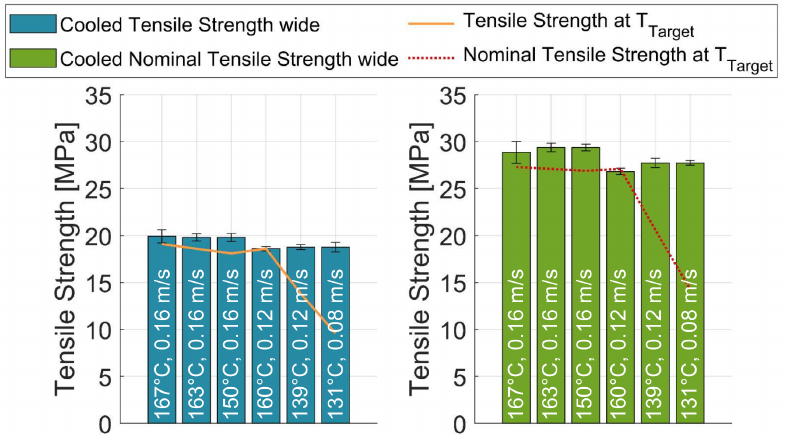
Figure 8. Standard and nominal transverse tensile strength of the cooled specimens at 100 mm cooling distance with the reference tensile strengths for unheated specimens at the achieved heated